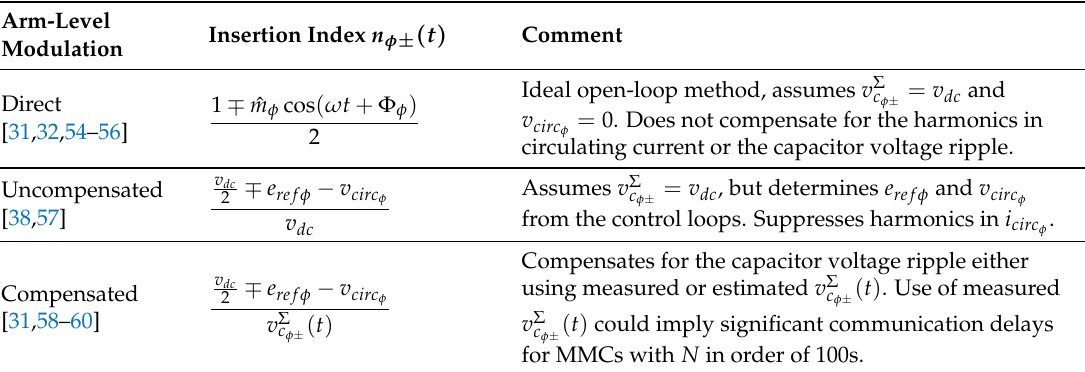
Table 2. Arm-level modulation